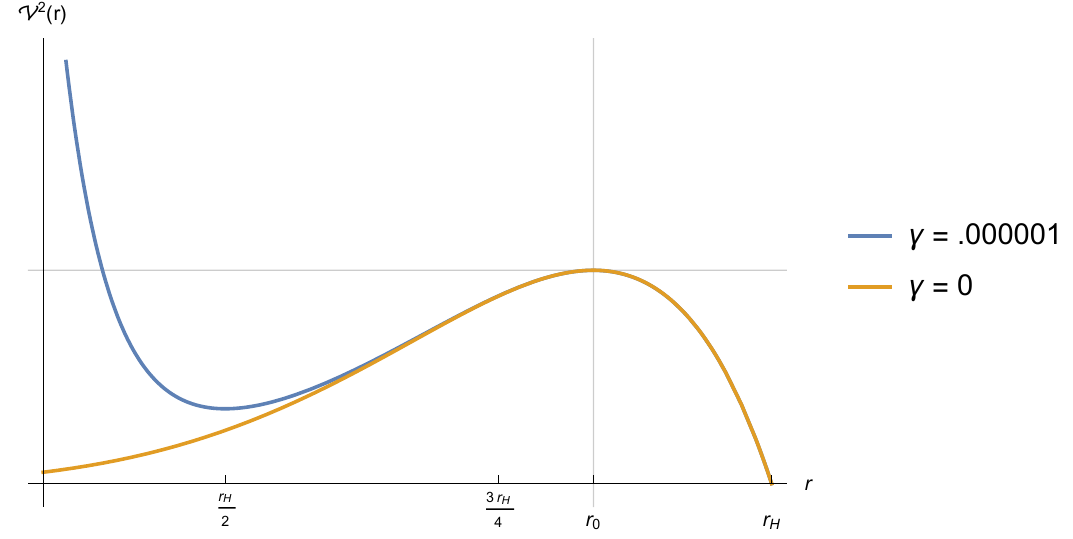
2 ( r ) of the volume functional for both the Weyl 4 -corrected AdS- Figure 11. The square V Schwarzschild geometry and the uncorrected geometry. The drastic difference in behavior between the two theories is clearly